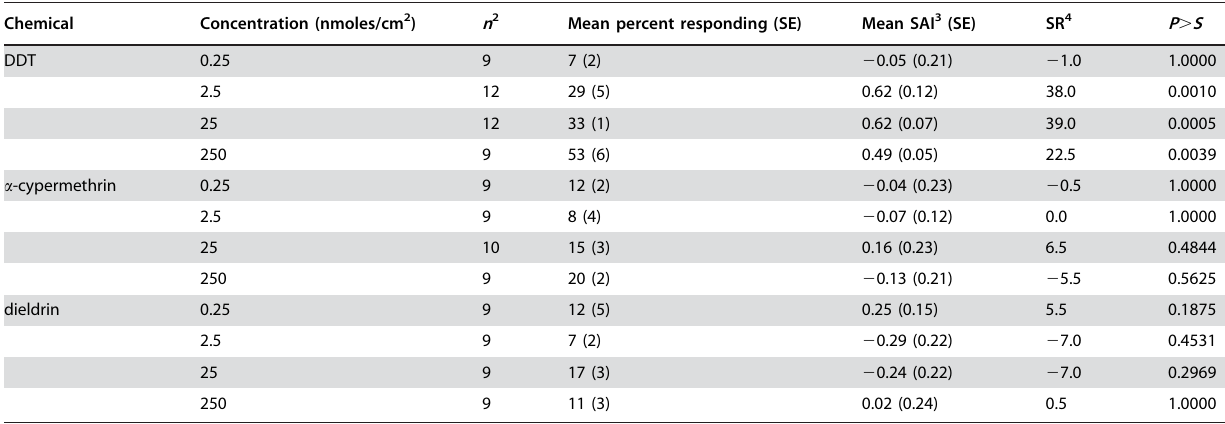
Table 2. Response of female Aedes aegypti 1 in the spatial repellency assay to selected chemicals in the laboratory. .. ... .... ... ... .... ... ... .... ... ... .... ... ... .... ... ... .... ... ... .... ... ... .... ... ... .... ... ... .... ... ... .... ... ... .... ... ... .... ... ... .... ... ... . Chemical Concentration (nmoles/cm 2 )